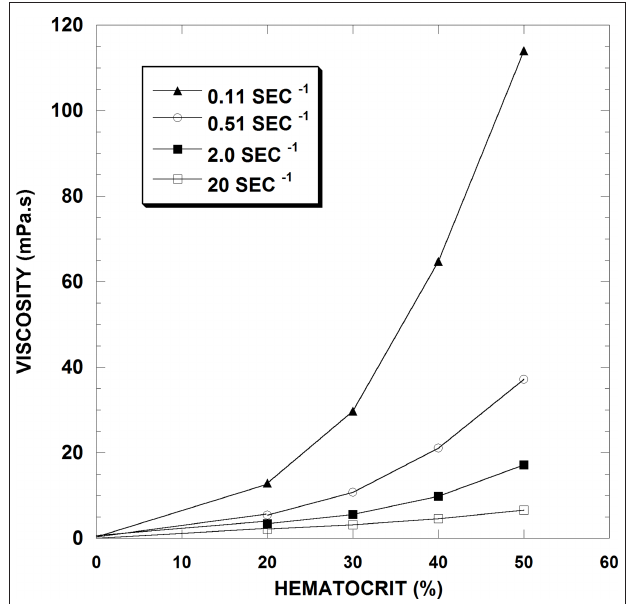
Figure 2 | Hematocrit-viscosity data at four shear rates for normal human rBC in plasma (From Cokelet and Meiselman,